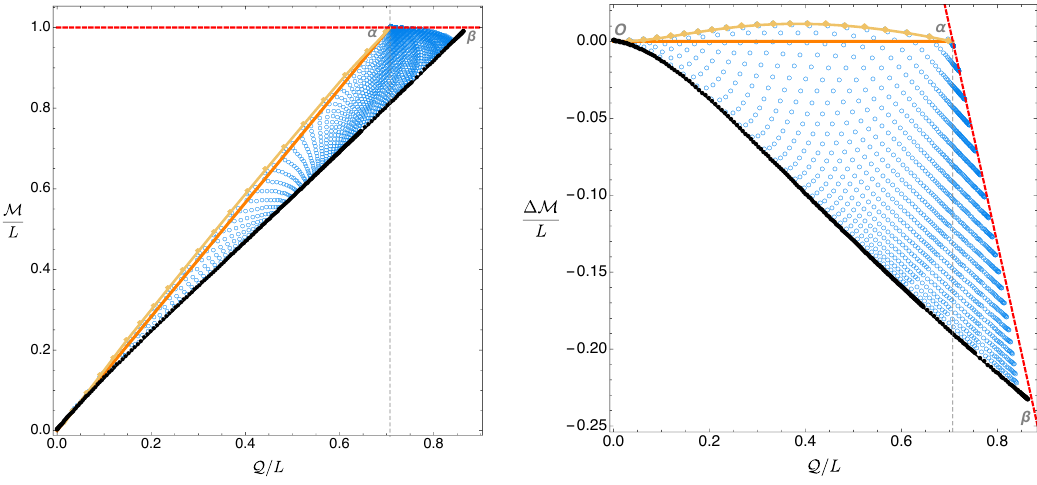
) in a Figure 10 . Phase diagram for Einstein theory with a scalar field charge e = 2 . 3 ( e > e S Minkowski box. In the left panel we have the Q - M phase diagram: we see that the solutions pile up and this is why we have instead been plotting the phase diagram Q - ∆ M (right panel). The blue circles describe hairy black holes, the black disk curve is the perturbative soliton family and the orange line is the extremal RN BH (RN black holes exist above it). The yellow curve is the superradiant onset curve of RN. As it could not be otherwise, it agrees with the hairy solutions in the limit where these have (cid:15) = 0 and thus merge with RN family. The gray and red dashed curves have the same interpretation as in figure 4. For e > e , the zero entropy limit of the hairy BH is S the soliton (black disk curve) in the sense that they have the same ( Q , M ) /L as the